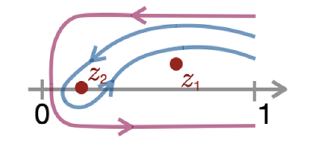
Figure 4 . Universal R -matrix acting on a